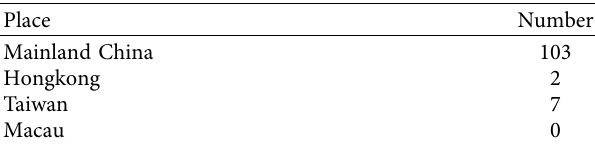
Table 5: MA theses related to Robinson Crusoe .